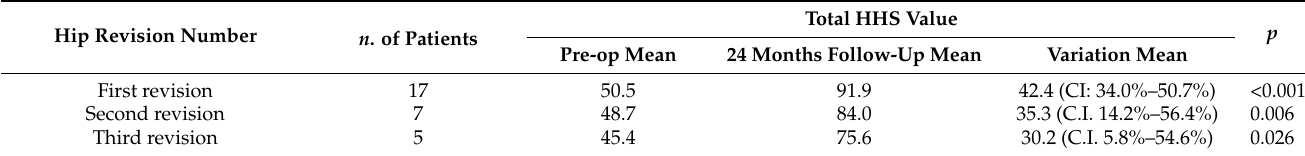
Table 8. Total HHS pre-op vs 24 months’ follow-up values in subgroups of hip revision